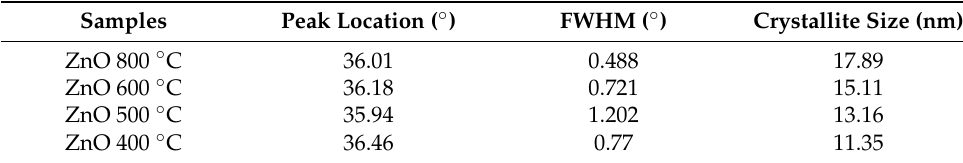
Figure 2. ( a ) X-ray diffraction spectra of ZnO from various sintering temperatures, ( b ) particle size curve plot (101) towards T sintering, and ( c ) Arrhenius plot to determine activation energy. Table 1. The crystallite size of ZnO powder samples.